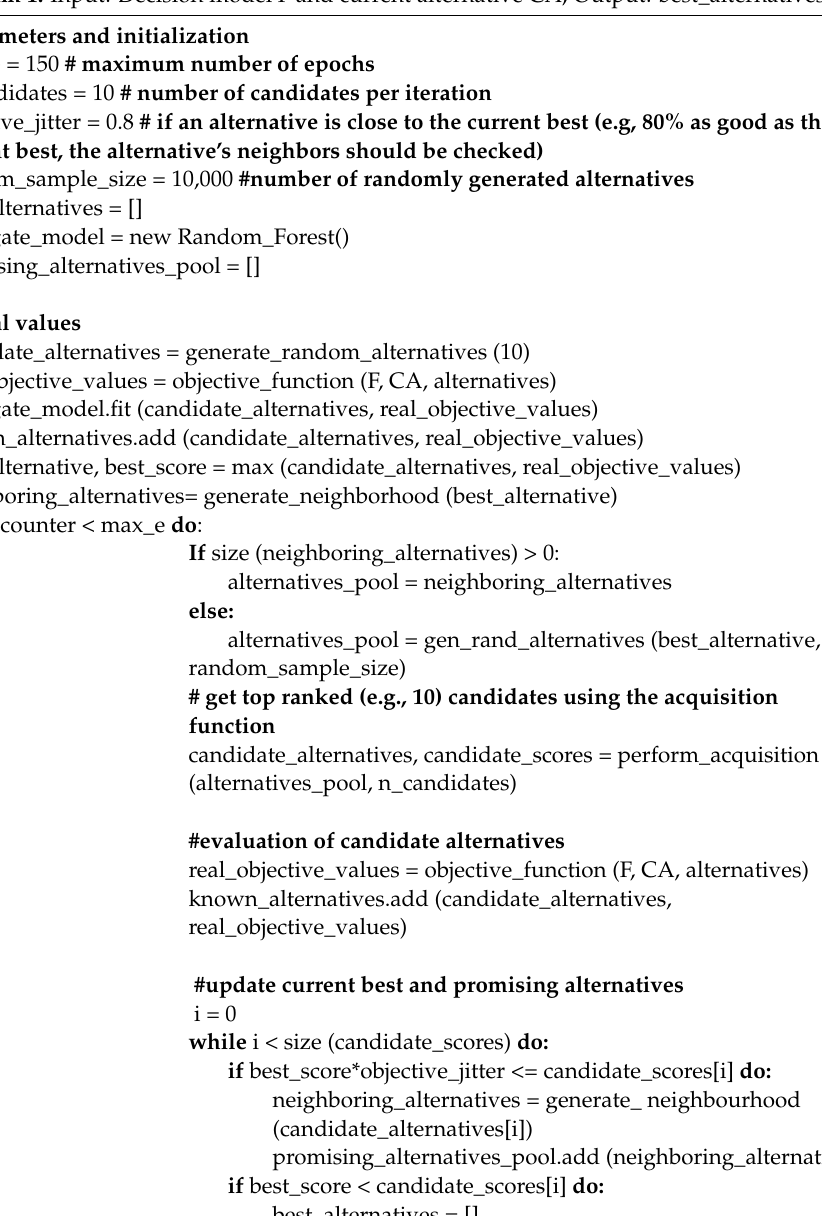
Algorithm 1: Input: Decision model F and current alternative CA; Output: